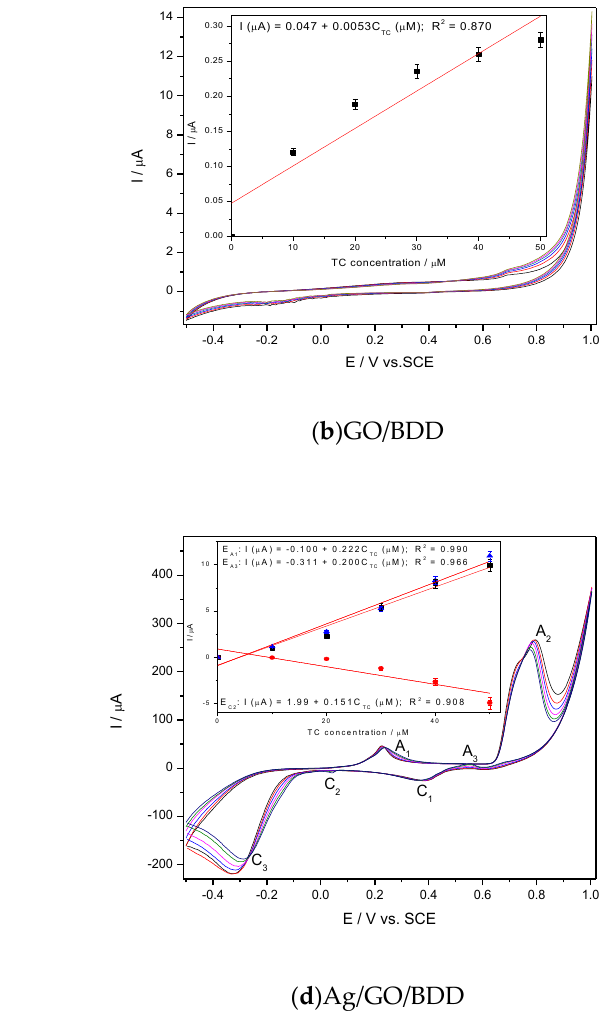
Figure 2. Cyclic voltammetry (CV) recorded at the scan rate of 0.05 V · s − 1 in 0.1M NaOH supporting electrolyte and tetracycline (TC) concentrations ranged from 10 to 50 µ M on the electrode: BDD ( a ); GO/BDD ( b ); Ag/BDD ( c ) and Ag/GO/BDD ( d ); Insets: Calibrations plots of peak current vs. TC concentrations at the potential value specific to each electrode: E = +0.700V/SCE (saturated calomel electrode) ( a ); E = +0.700 V/SCE ( b ); E 1 = +0.285 V/SCE, E 2 = +0.550 V/SCE, E 3 = +0.670 V/SCE ( c ); E 1 = +0.039 V/SCE (cathodic), E 2 = +0.296 V/SCE, E 3 = +0.550 V/SCE, E 4 = +0.670 V/SCE ( d